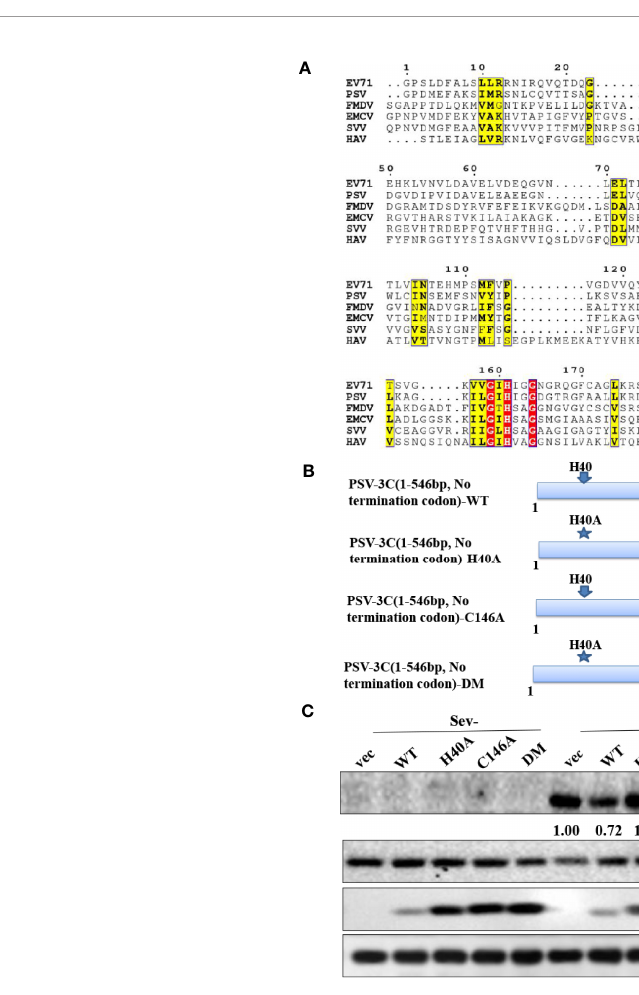
FIGURE 3 | PSV 3C pro suppresses Sev-induced type I IFN production dependent on its protease activity of 3C. (A) Amino acid sequence alignment results of 3C pro derived from PSV (MT080999), SVV (APA28975), FMDV (NP74046), EMCV (NP740410), HAV (AKI05745), and EV71 (AFP66570). (B) Schematic diagram of PSV 3C pro and its mutants. (C) HEK293T cells were transfected with 500 ng HA-3C or its mutants for 20 h, and then the cells were infected or not with Sev (2 5 HA) for 9 h. The cells were collected for Western